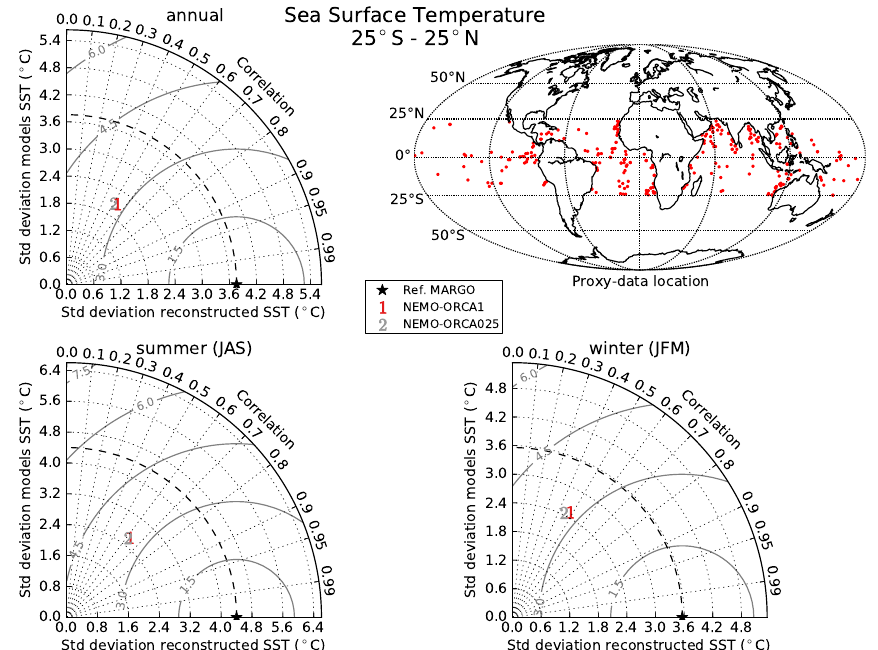
Fig. 11. Taylor diagrams summarizing the correlation coefficient, the standard deviations and RMSE for the LGM annual, boreal winter (JFM) and boreal summer (JAS) modelled and reconstructed sea surface temperatures between 25 ◦ S and 25 ◦ N. The proxy-data locations are shown in the upper right-hand diagram. The NEMO-ORCA1 is symbolized with the number 1, NEMO-ORCA025 with the symbol 2.